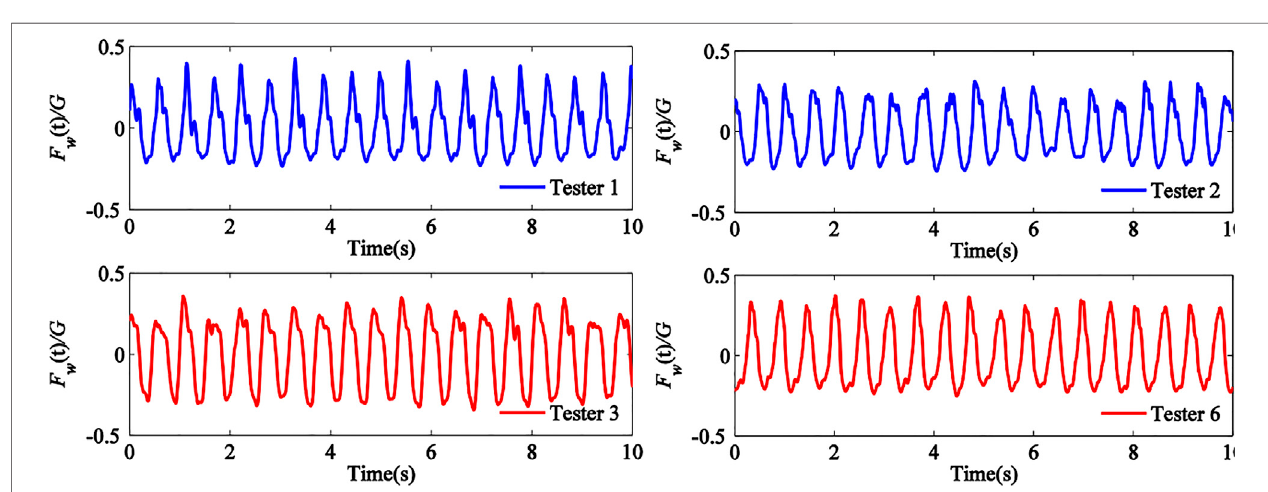
FIGURE 9 | Time histories of non-dimensional pedestrian walking loads for multi-person